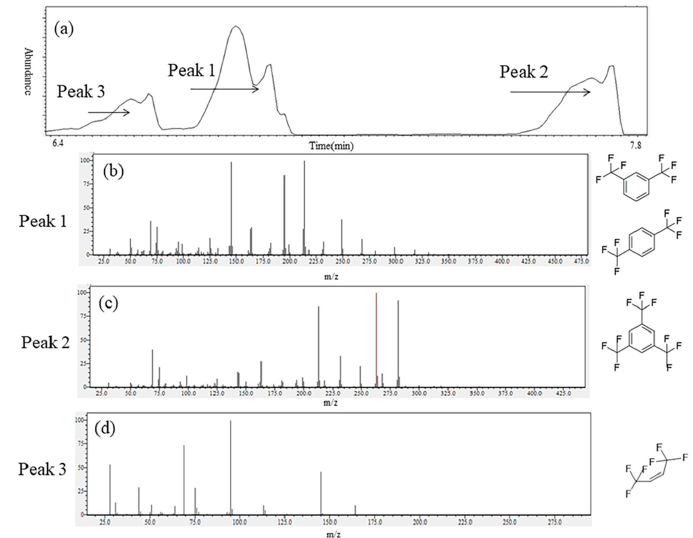
Figure 5. GC–MS results of oily liquids collected from the inner wall of the quartz tube. ( a ): Gas chromatogram of oily liquids products; ( b ): Mass spectrum of Peak 1; ( c ): Mass spectrum of Peak 2; ( d ): Mass spectrum of Peak